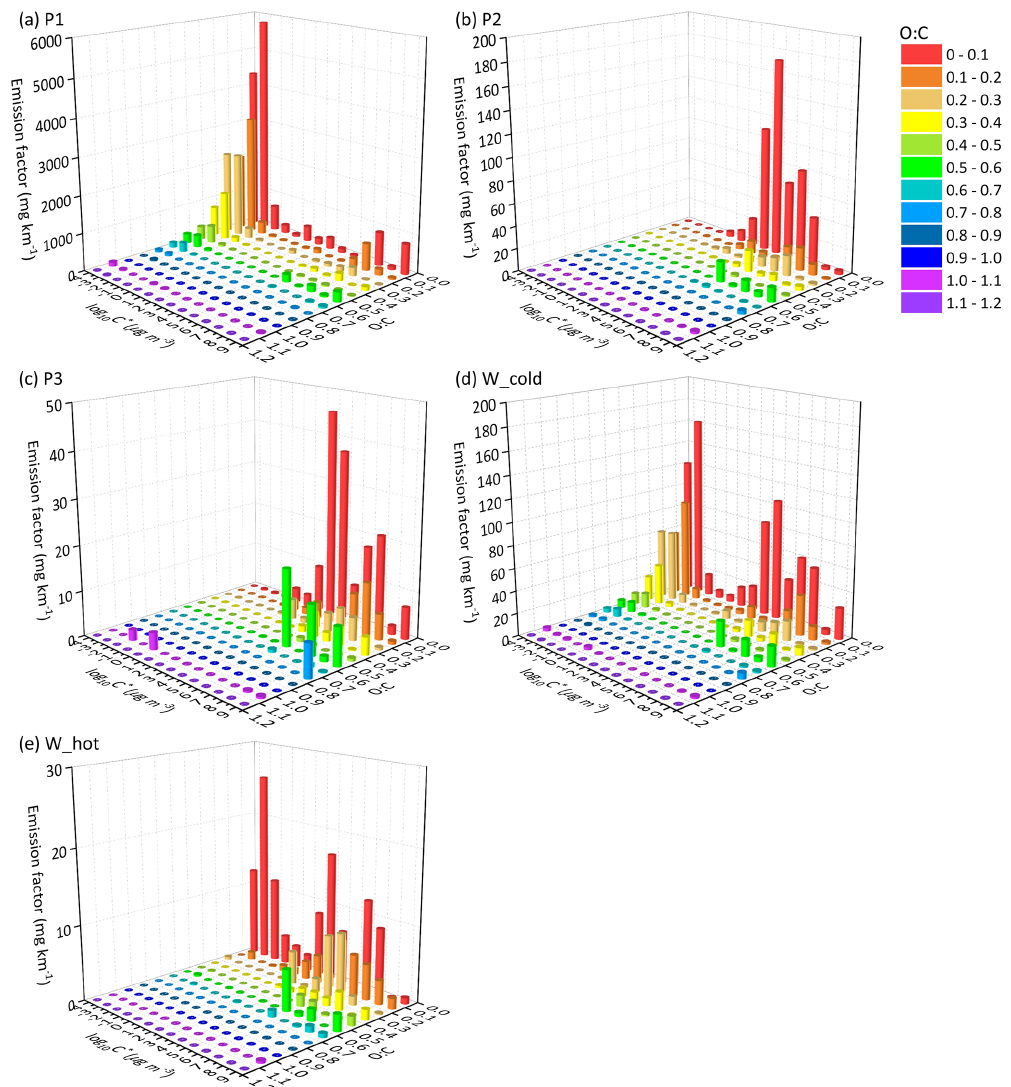
Figure 3. The EF distribution of the speciated I/SVOCs of non-(DPF + DOC) vehicles on a 2D-VBS space of (a ) low-speed-stage (P1), (b) middle-speed-stage (P2), (c) high-speed-stage (P3), (d) whole (W_cold), and whole (W_hot) driving cycles. Different colors indicate different O:C ratios segmented into 12 bins: 0–0.1, 0.1–0.2, 0.2–0.3, 0.3–0.4, 0.4–0.5, 0.5–0.6, 0.6–0.7, 0.7–0.8, 0.8–0.9, 0.9–1.0, and